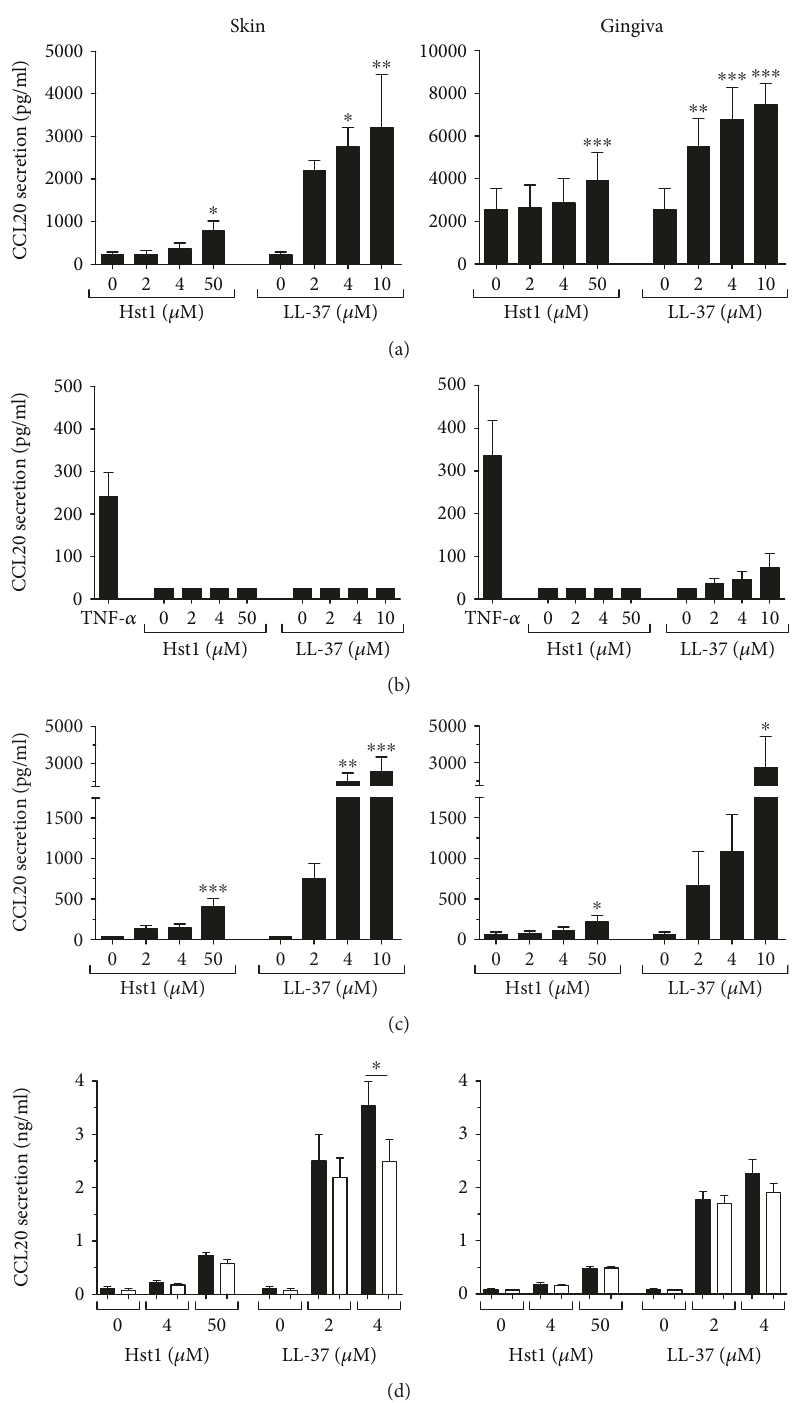
Figure 2: CCL20 secretion after Hst1 and LL-37 exposure. Skin or gingiva cells were exposed to either Hst1 or LL-37 for 24 hours, and CCL20 secretion was assessed by ELISA. (a) Keratinocyte monoculture, (b) fi broblast monoculture, and (c) keratinocyte- fi broblast coculture. (d) Keratinocyte- fi broblast coculture exposed to Hst1 and LL-37, together with either neutralizing antibodies to IL-1 α (white bars) or isotype control (black bars). Each bar represents the mean ± standard error mean of 3 independent experiments each performed in duplicate, except that in (c) ( N = 4 ). ∗ P < 0 05 , ∗∗ P < 0 01 , and ∗∗∗ P < 0 005